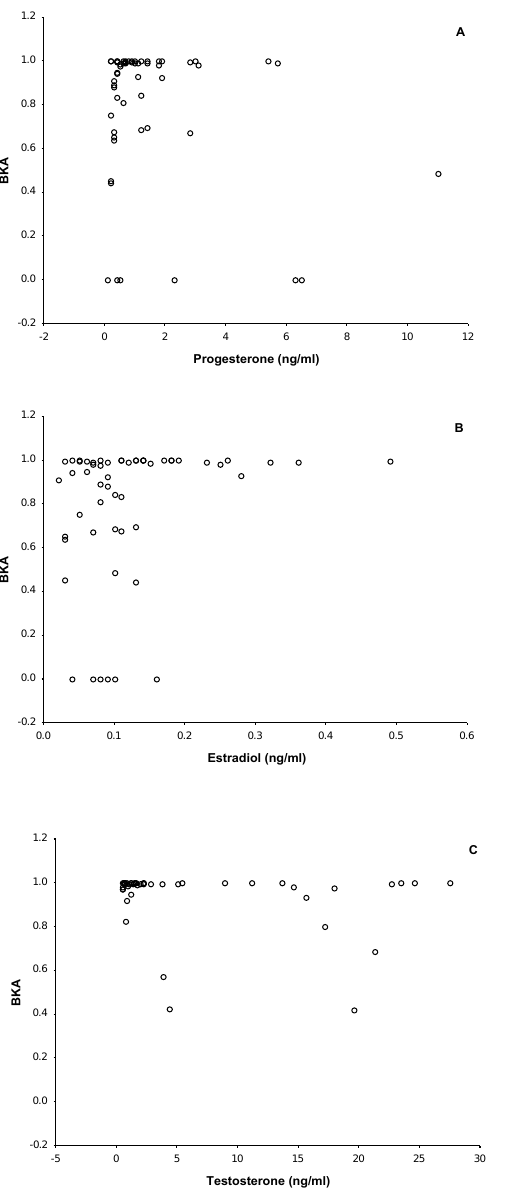
Figure 5. Spearman Rank correlation analyses between bacterial killing ability (BKA) and steroid sex hormone concentration in female ( A , B ) and male ( C ) fish-eating myotis in Partida Norte Island, Mexico. Only BKA and estradiol concentration were significantly correlated.